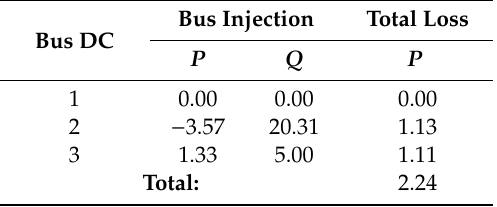
Table A15. Results of the mixed AC / DC PF calculations in Case 4. DC bus data.